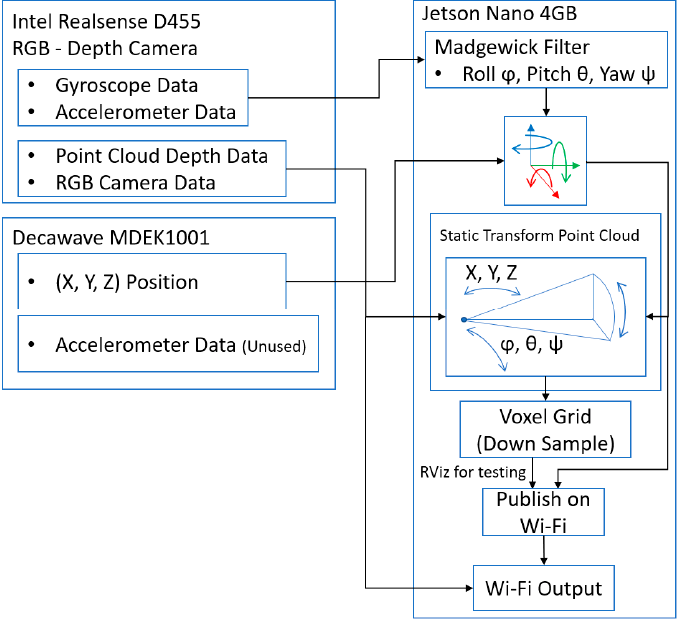
Figure 5. Base system—Jetson Block Diagram.